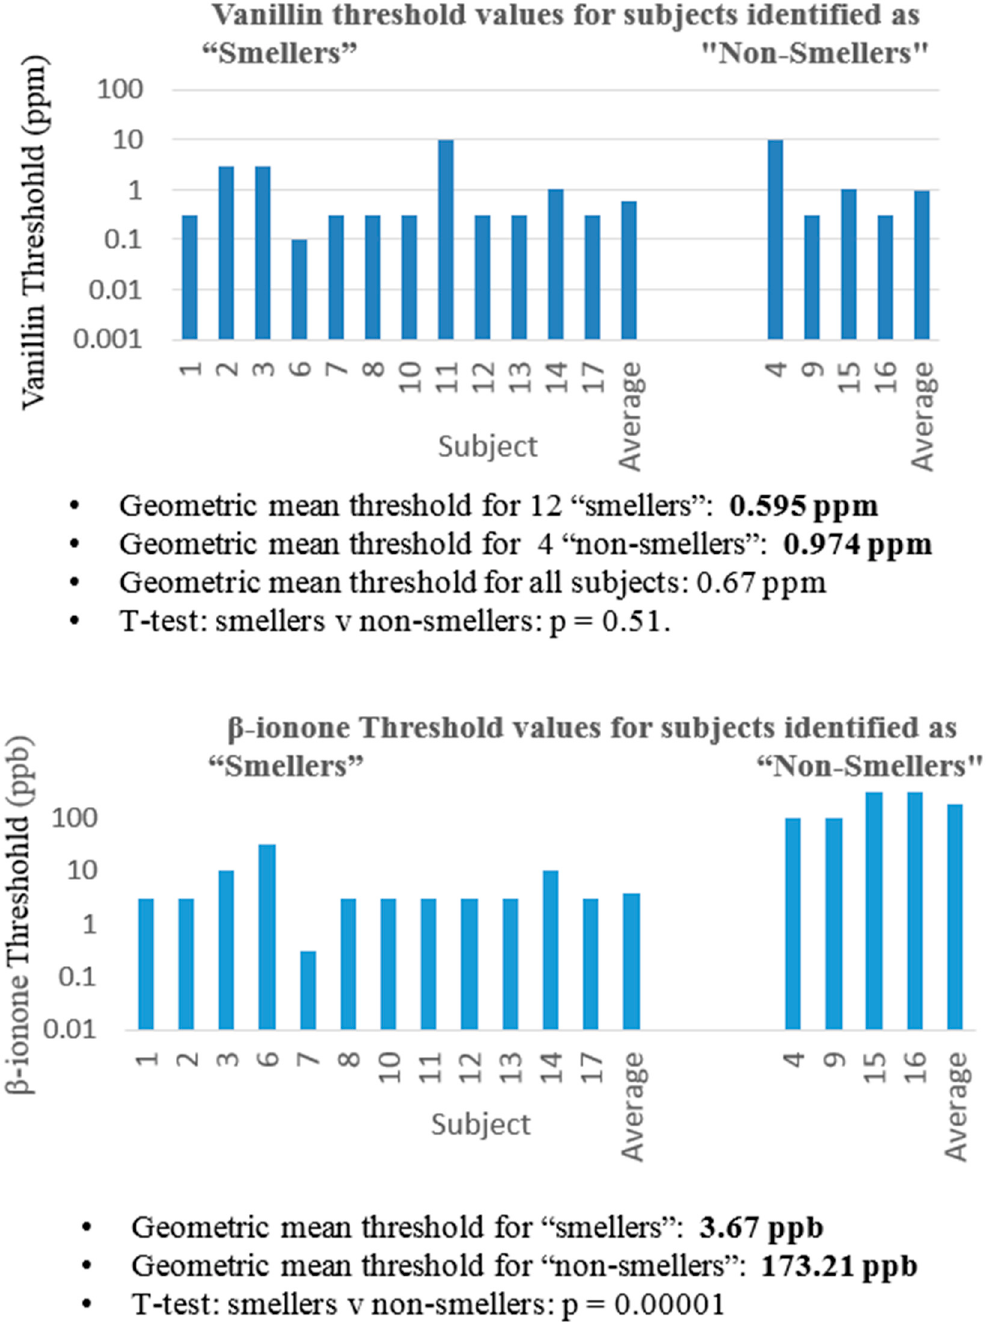
Figure 3. Odor mixture interactions: genetics. Vanillin thresholds do not differ for ‘smellers’ and non-smellers of β -ionone. β -ionone thresholds for ‘non-smellers’ are all higher than thresholds for ‘smellers’. From [22]. The β -ionone smeller detects a ‘violet-flower’ odor; whereas, the non-smeller detects ‘woody’. Results are generally consistent with McRae et al. [23], who found ‘non-smellers’ of β -ionone to have a threshold more than an order of magnitude higher than ‘smellers’.